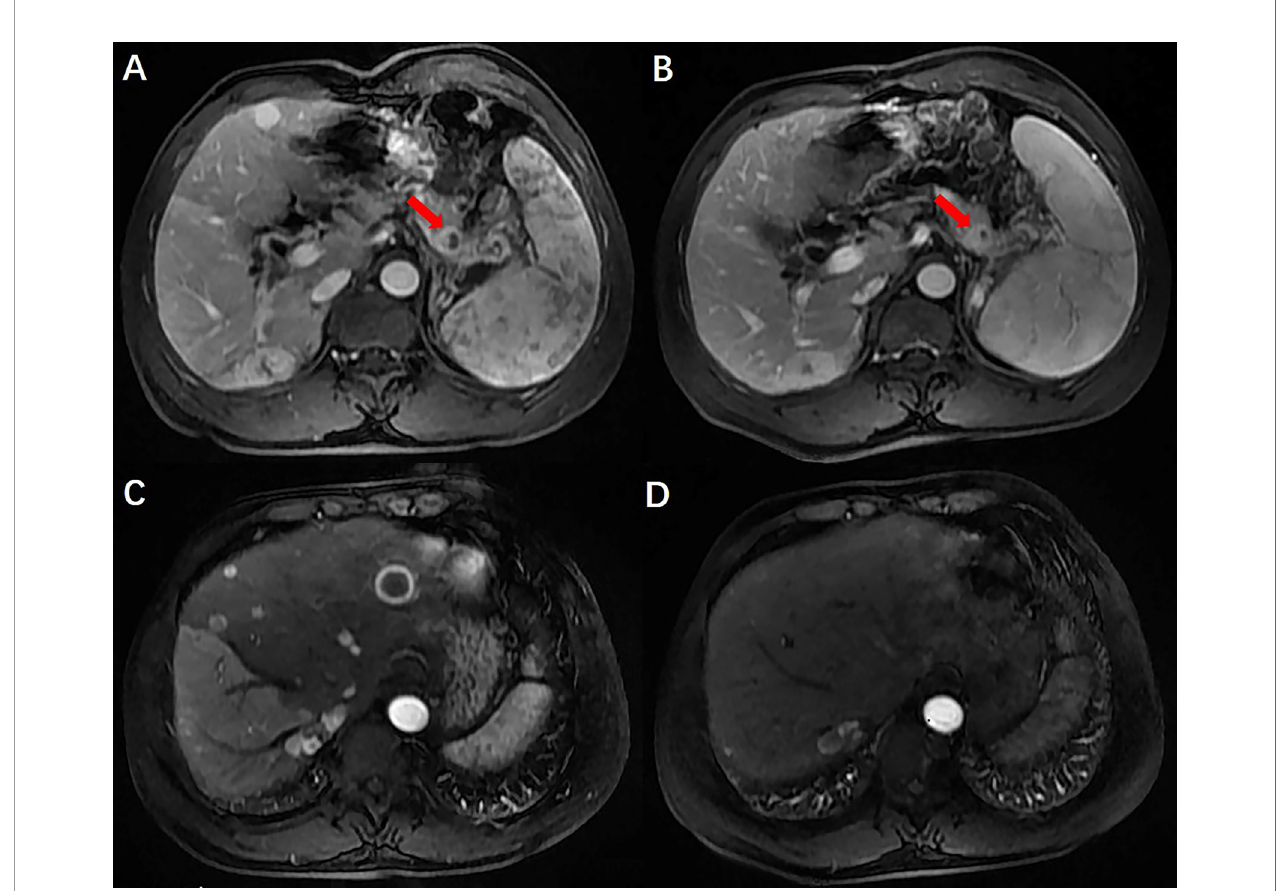
FIGURE 2 | Preoperative and postoperative comparison of PNENs and liver metastases. There was no change in the size of the pancreatic lesion and intrahepatic tumor of the patient was